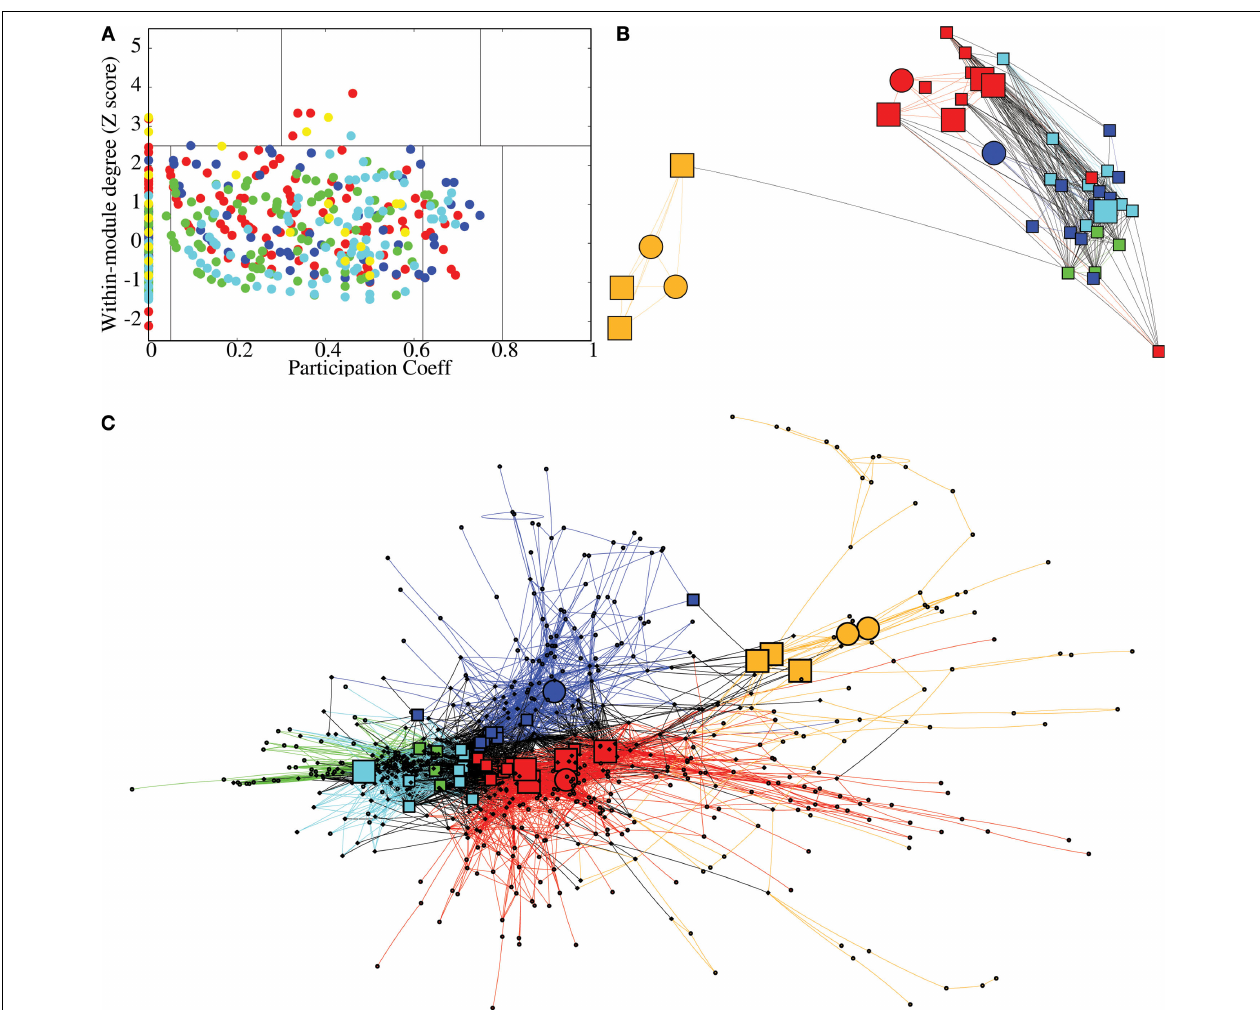
FIGURE 4 | Topological roles of network nodes in intra- and inter-modular connectivity. (A) All nodes are plotted in the { P − z } plane of intra-modular degree z vs participation coeffi cient P ; the solid lines partition the plane according to criteria for hubs vs non-hubs and connector, provincial, peripheral or kinless nodes. (B) Anatomical representation of the provincial hubs (circles), connector hubs (large squares) and connector nodes (small squares)